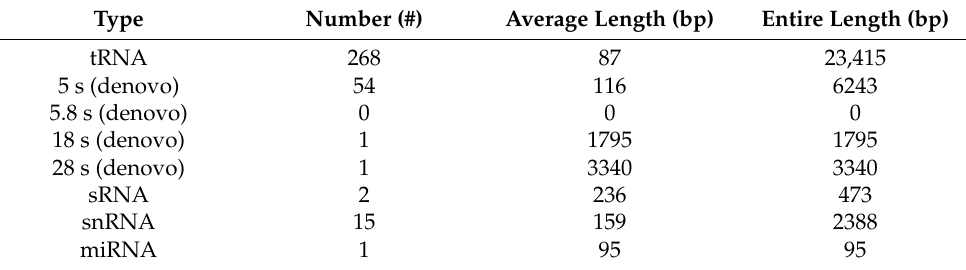
Table 4. A. rasikravindrae genome data related